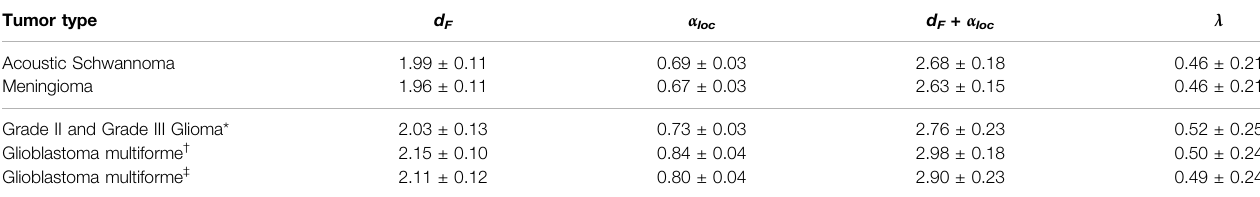
TABLE 1 | Scaling analysis results for dynamical parameters.